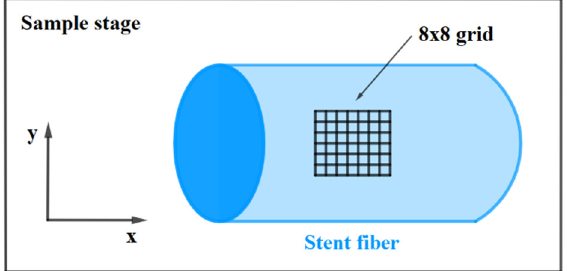
Figure 2. A principal scheme of the Raman measurements. The excitation laser beam impinges on the sample in the z (vertical) direction.